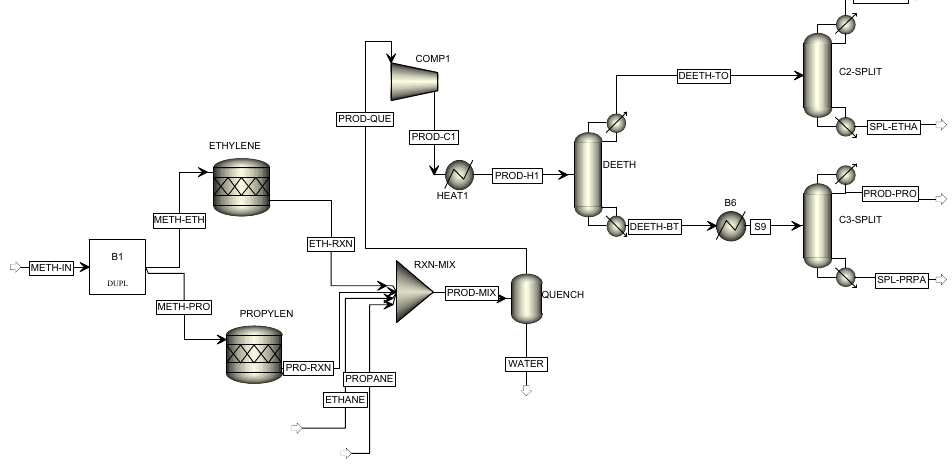
Figure A1. The ASPEN Plus Simulation Flowsheet for the MTO